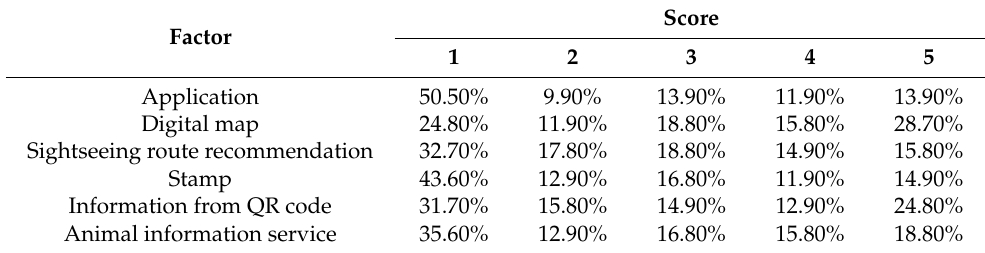
Table 12. Results (Performance) of the second-level questionnaire (Smartphone application(s)). Factor